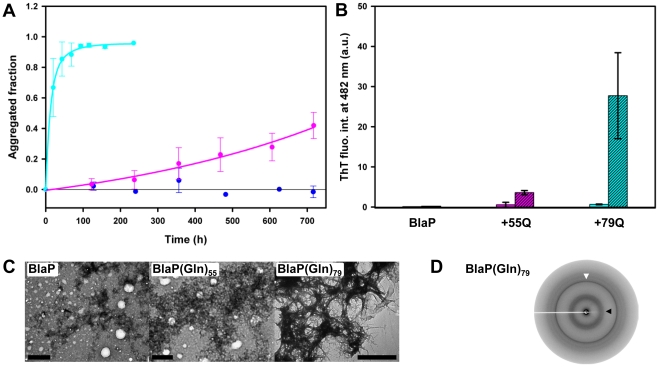
Only BlaP(Gln)79 form amyloid-like fibrils when incubated under native conditions.(A) Aggregation kinetics of 110 µM BlaP (blue), BlaP(Gln)55 (pink) and BlaP(Gln)79 (cyan) at 37°C in PBS, pH 7.5, followed by measuring the concentration of protein remaining soluble. Time-points shown with an error bar are the average of three independent time-courses for BlaP(Gln)55 and BlaP(Gln)79 and two independent time-courses for BlaP. Error bars show the standard deviations. (B) ThT fluorescence intensities at 482 nm in the presence of BlaP and chimeras samples at T0 (solid bars) and Tf (dashed bars). T0 and Tf correspond to the initial and final points of one time-course for each protein. Data are the average of three measurements and error bars represent the standard deviations. ThT fluorescence intensities in the presence of BlaP samples are weak and for more visibility, error bars (which are equal or less than to 0.3) are not shown. a.u., arbitrary units. (C) TEM images of the protein samples at Tf. The scale bar is 1 µm. (D) X-ray fibre diffraction pattern from BlaP(Gln)79 fibrils at Tf. White and black arrows indicate meridional and equatorial reflections at 4.7 Å and ca. 9.5 Å, respectively.